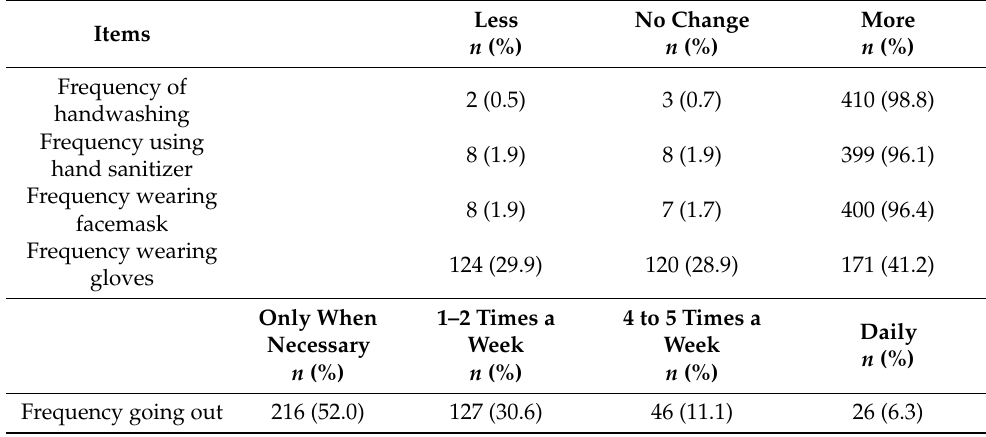
Table 6. Practices during the COVID-19